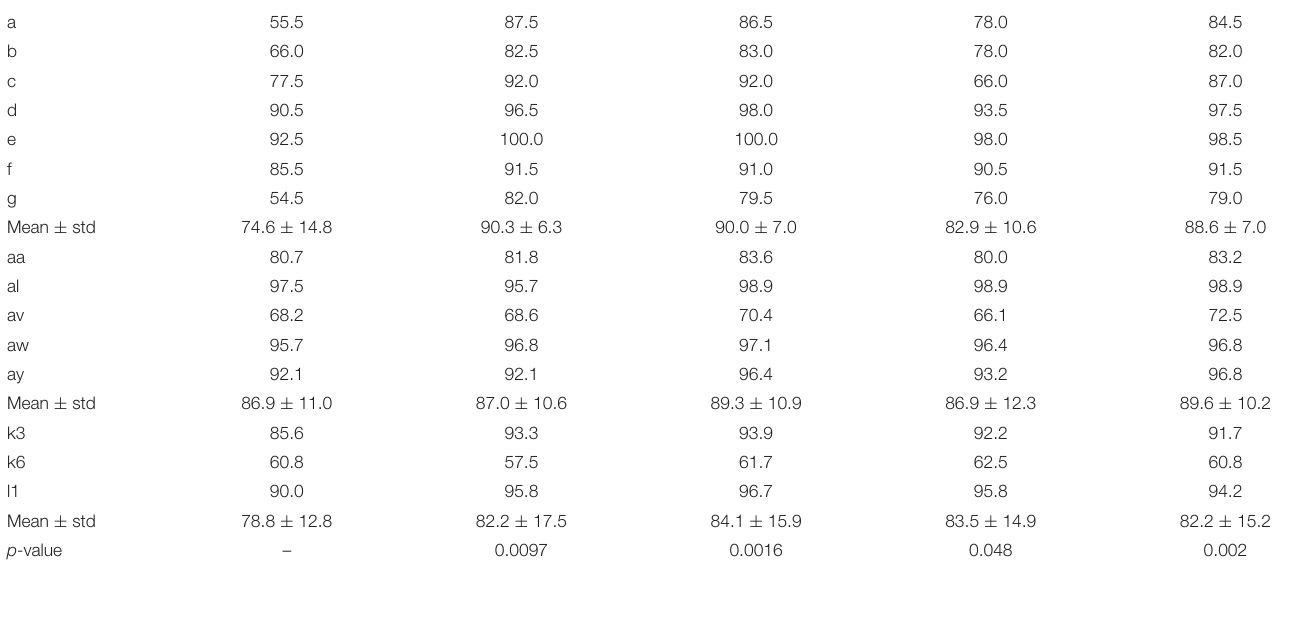
TABLE 1 | Accuracy (%) and significance comparisons of different methods applied on dataset 1, 2, and 3. Participant